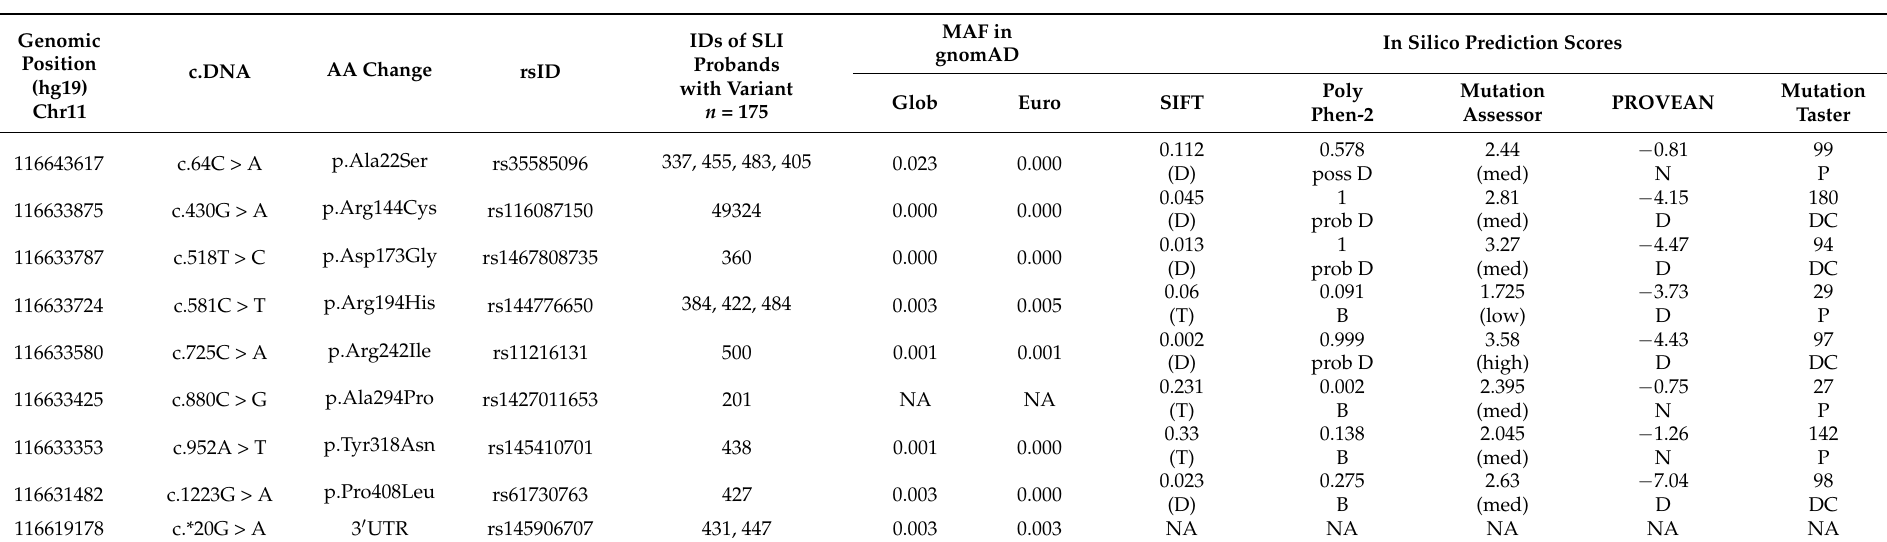
Table 4. Summary of rare variants in BUD13 (NM_032725.4) identified through Sanger sequencing in probands with